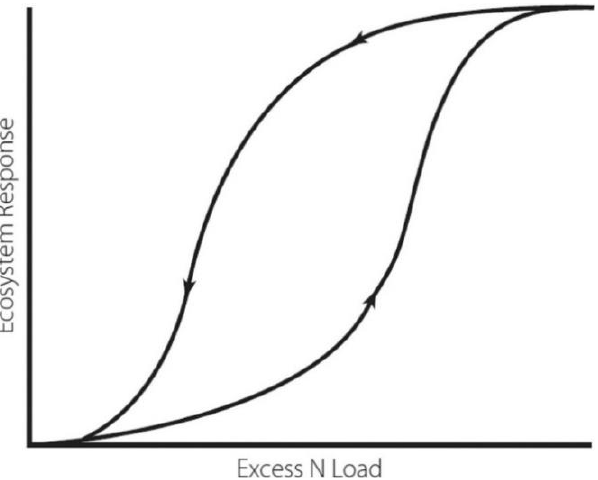
Figure 3. Hysteretic model for responses of terrestrial ecosystems to atmospheric deposition of N. Note lack of units and variables, as this is a conceptual model, with variables and units varying by ecosystem process and N status of the ecosystem. Reprinted with permission from ref. [28]. Copyright 2019 Gilliam et al.